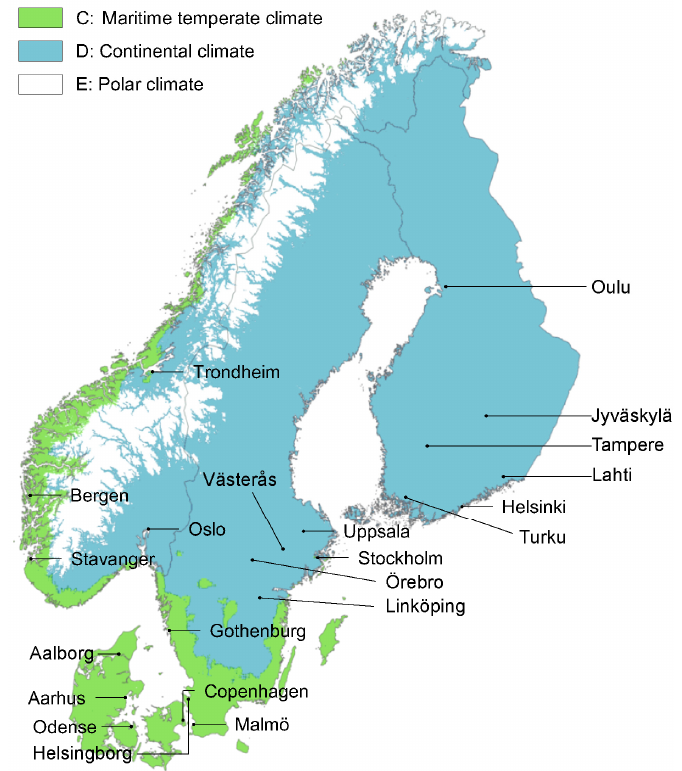
Figure 1. Climate Classification map for Nordic countries according to the Köppen–Geiger system—all cities above 100,000 inhabitants are marked (2016). Reprinted with permission from Ref. [6].